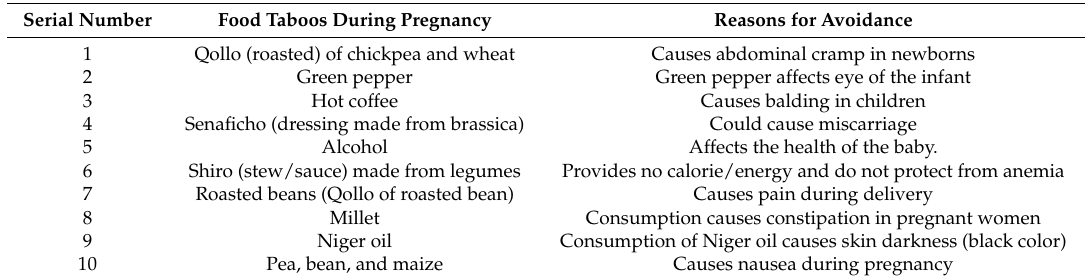
Table 2. Food taboos and the reasons for their avoidance during pregnancy in the study communities, Tigray, Northern Ethiopia,